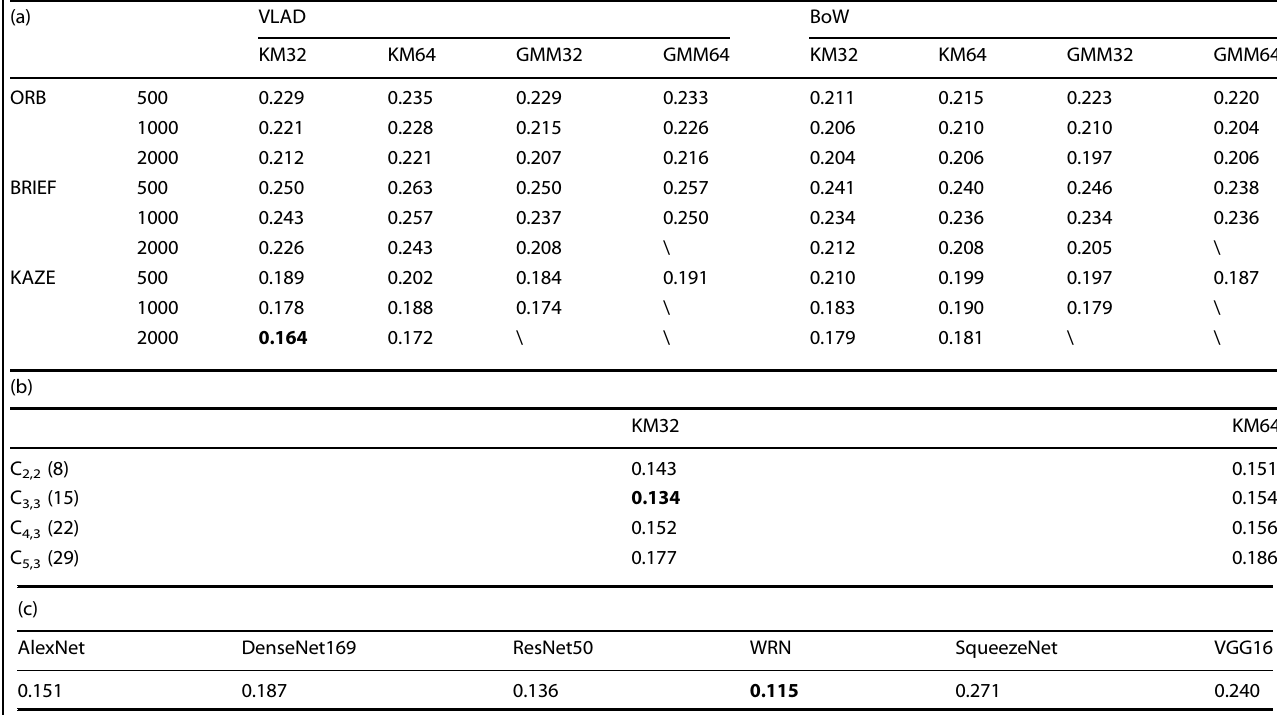
Table 1. Model performances (given in MAPE) for hyperparameter tuning or model